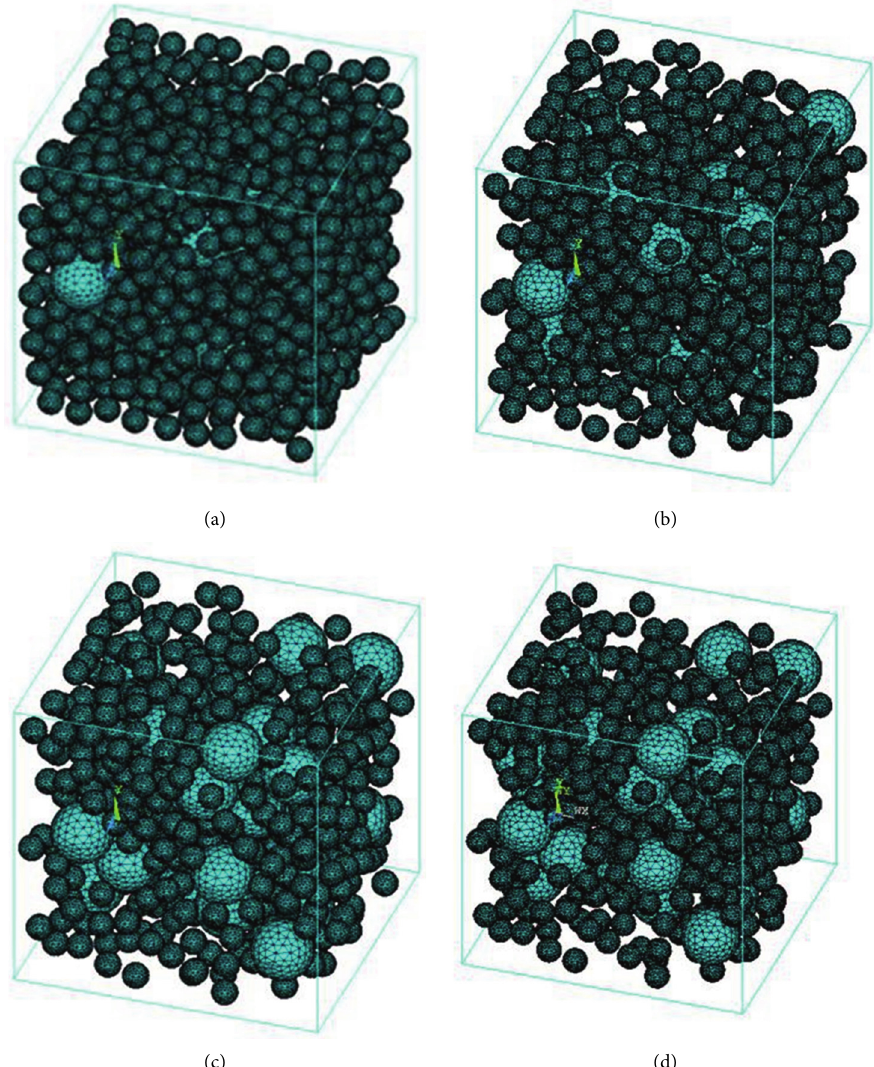
Figure 3: The three-dimensional microanalysis for the concrete with large size cobbles at different gradations: (a) 20%: 80%; (b) 30% :70%; (c) 40% :60%; (d) 50%